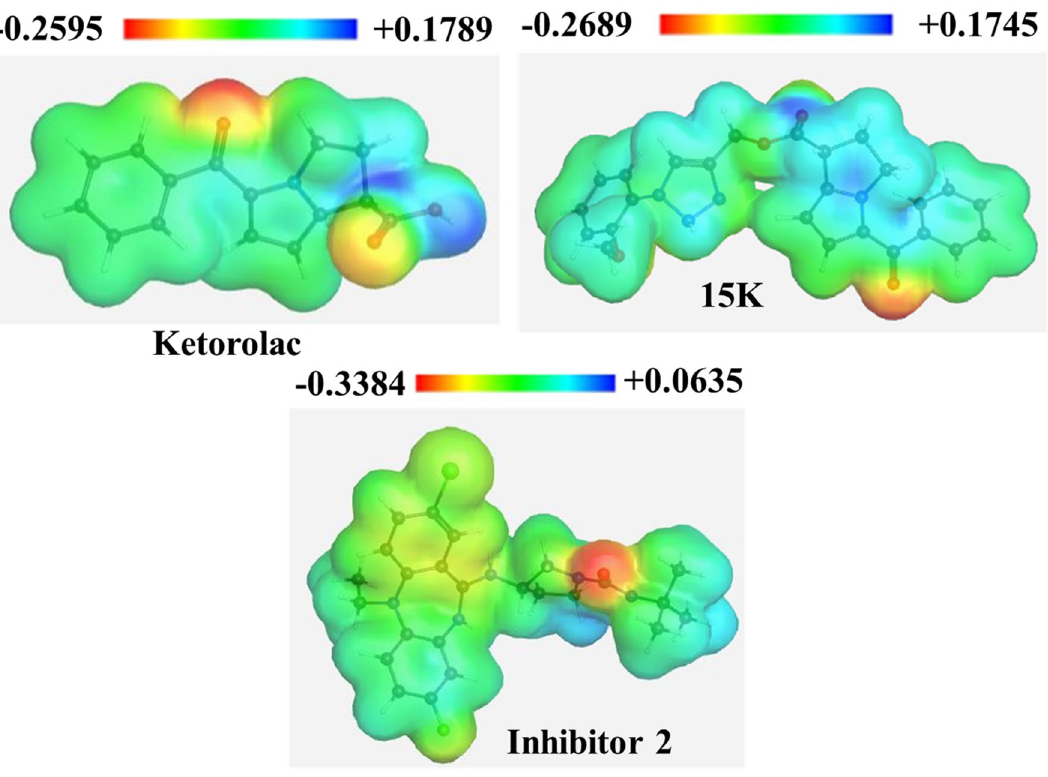
Figure 3. Molecular electrostatic potential map of ketorolac, 15K, and inhibitor